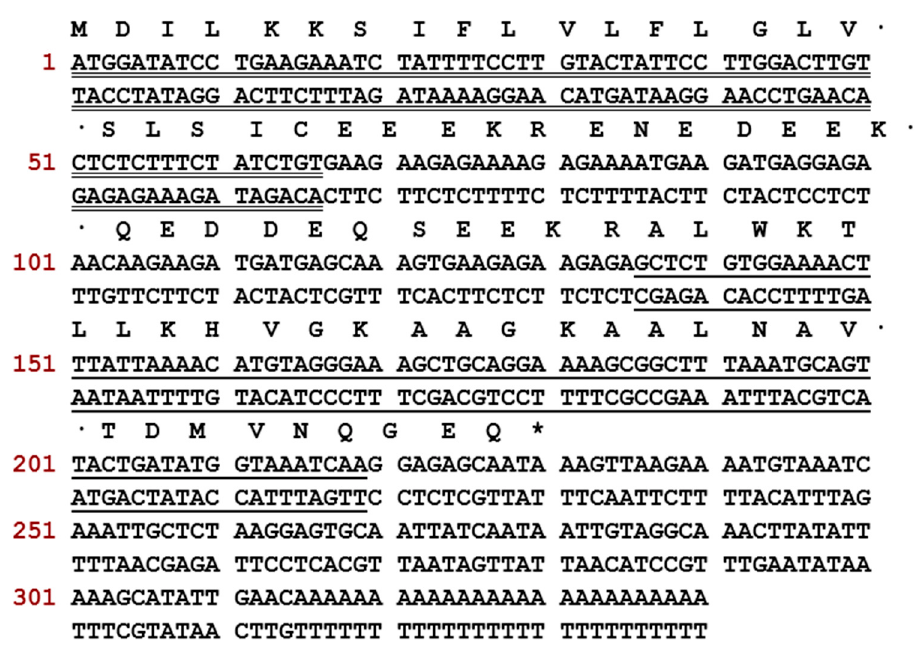
Figure 1. Nucleotide sequence and related open-reading frame of Der-PS4 from the skin secretion of Phyllomedusa sauvagii . The putative signal peptide is double-underlined, the mature peptide is single-underlined and the stop codon is marked by an asterisk.